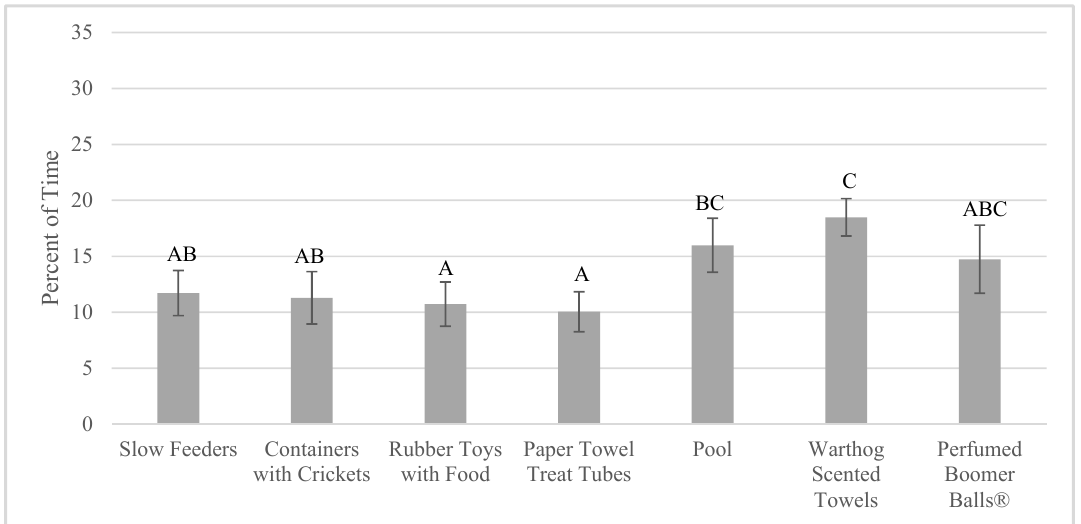
Figure 3. Percent of total time foraging when each enrichment item was available (mean ± SE; n = 4). Significant pairwise comparisons ( p < 0.05) are noted on the graph with different uppercase letters. Pairwise comparisons can be found in Table S5.